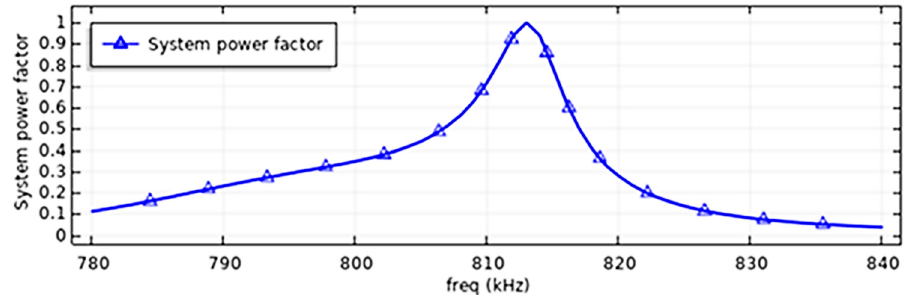
Figure 14. The relationship between power factor and operating frequency.